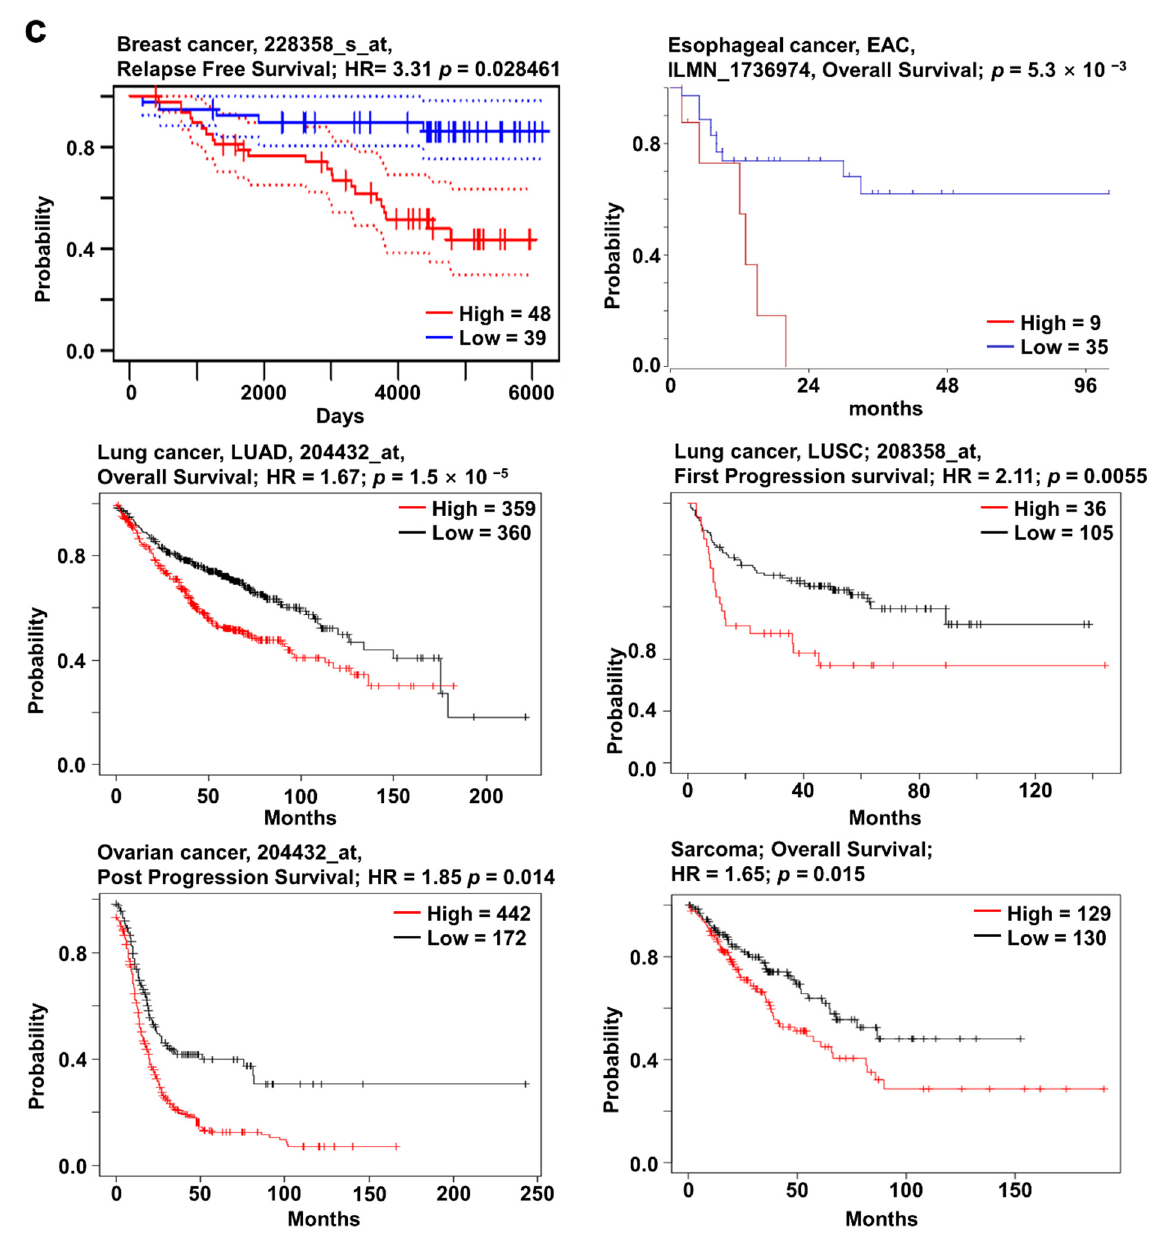
Figure 4. SOX12 expression pattern and patient survival in various cancers. SOX12 expression pattern, alteration frequency of mutations, copy number alterations, and patient survival in various types of cancers. ( a ) Box plots comparing specific SOX12 expression in normal (left plot) and cancer tissues (right plot) were derived from the Oncomine database. The fold-changes in SOX12 expression in breast, esophageal, lung, and ovarian cancers and sarcoma were determined and are shown as box plots. ( b ) The mutations and alteration frequency of SOX12 were determined using the cBioPortal database. SOX12 mutation diagram of different cancer types across protein domains is shown. SOX11 mutation mainly occurred in bladder cancer with one hot spot (E294K) representing the common founder mutations. The alteration frequency of SOX12 was determined using the cBioPortal database and is shown at the bottom. Only cancer types containing more than 100 samples and an alteration frequency of >2.1% are shown. The alterations comprised deletions (blue), amplification (red), or mutation (green). ( c ) The survival plot comparing patients with high (red) and low (blue) expression in various cancer types was obtained using the Kaplan–Meier plotter, PrognoScan, and R2 databases. Survival plot analysis was performed using a threshold Cox p- value of <0.05. Abbreviations. IDC: invasive ductal carcinoma; OSE: ovarian surface epithelium; OVC: ovarian carcinoma; EAC: esophageal adenocarcinoma.